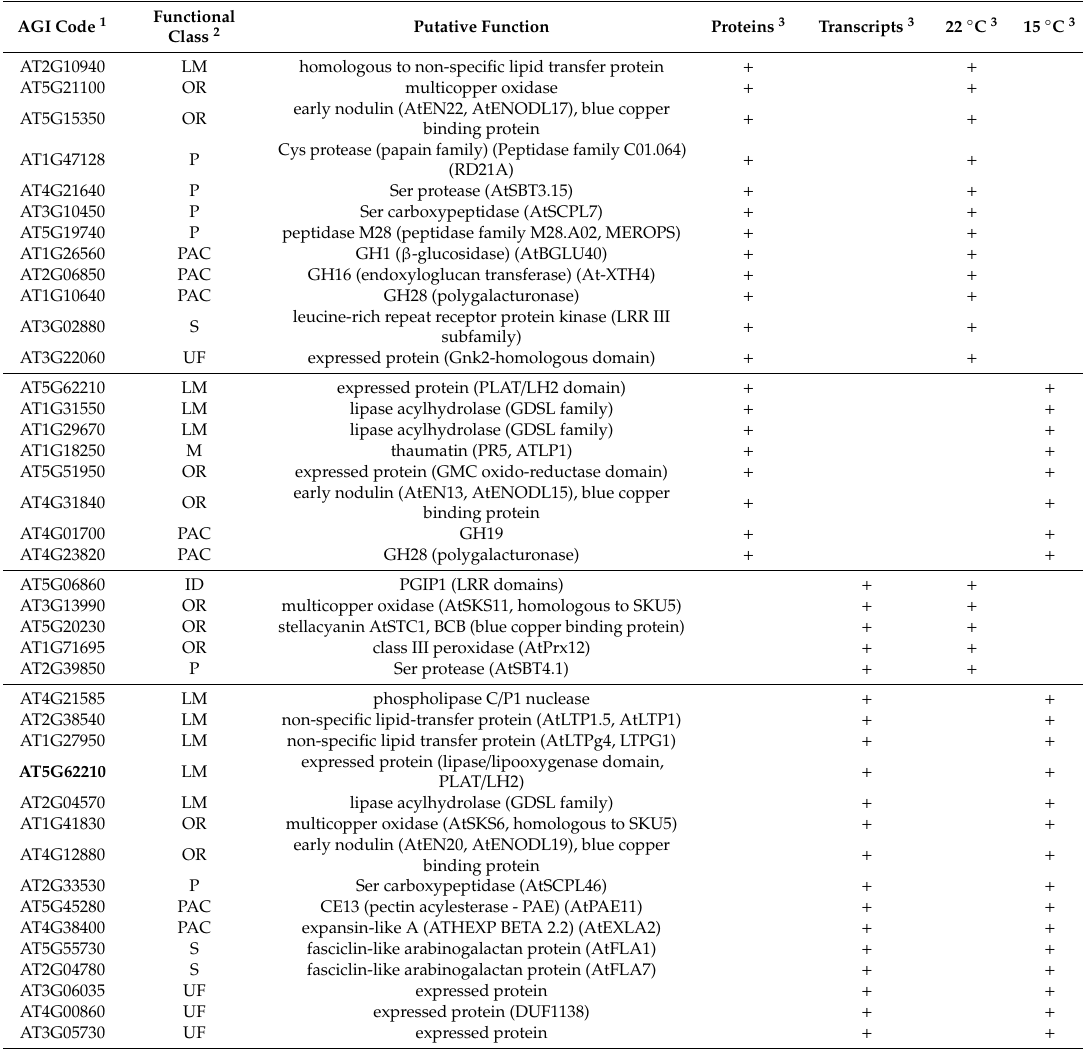
Table 3. Synopsis of CWPs or CW transcripts di ff erentially accumulated at a given growth temperature in floral